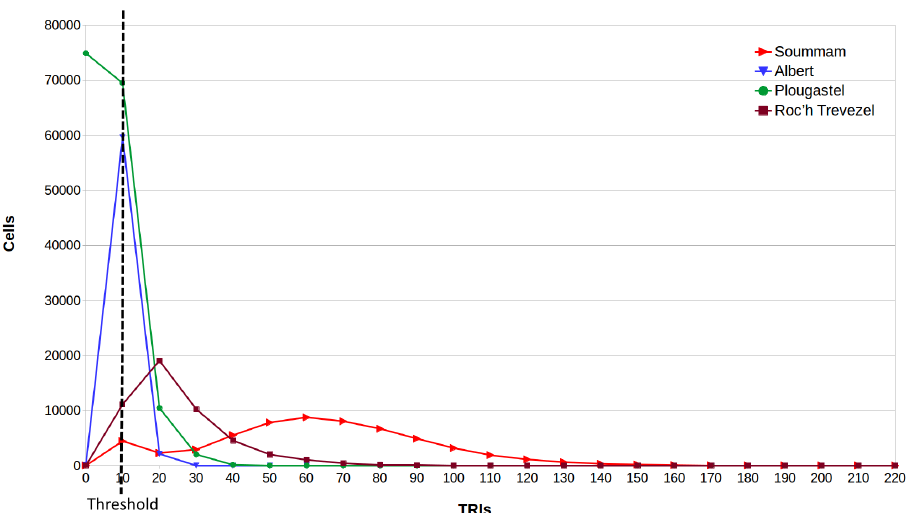
Figure 3. A histogram of topography ruggedness. Four zone analysis with high variability (red, the Soummam), low variability (blue, the City of Brest, with several deep valleys and the shore), a zone with an high percentage of sea surface (green, Brest bay), and medium variability with low size hills (brown, the Arrée mountains).